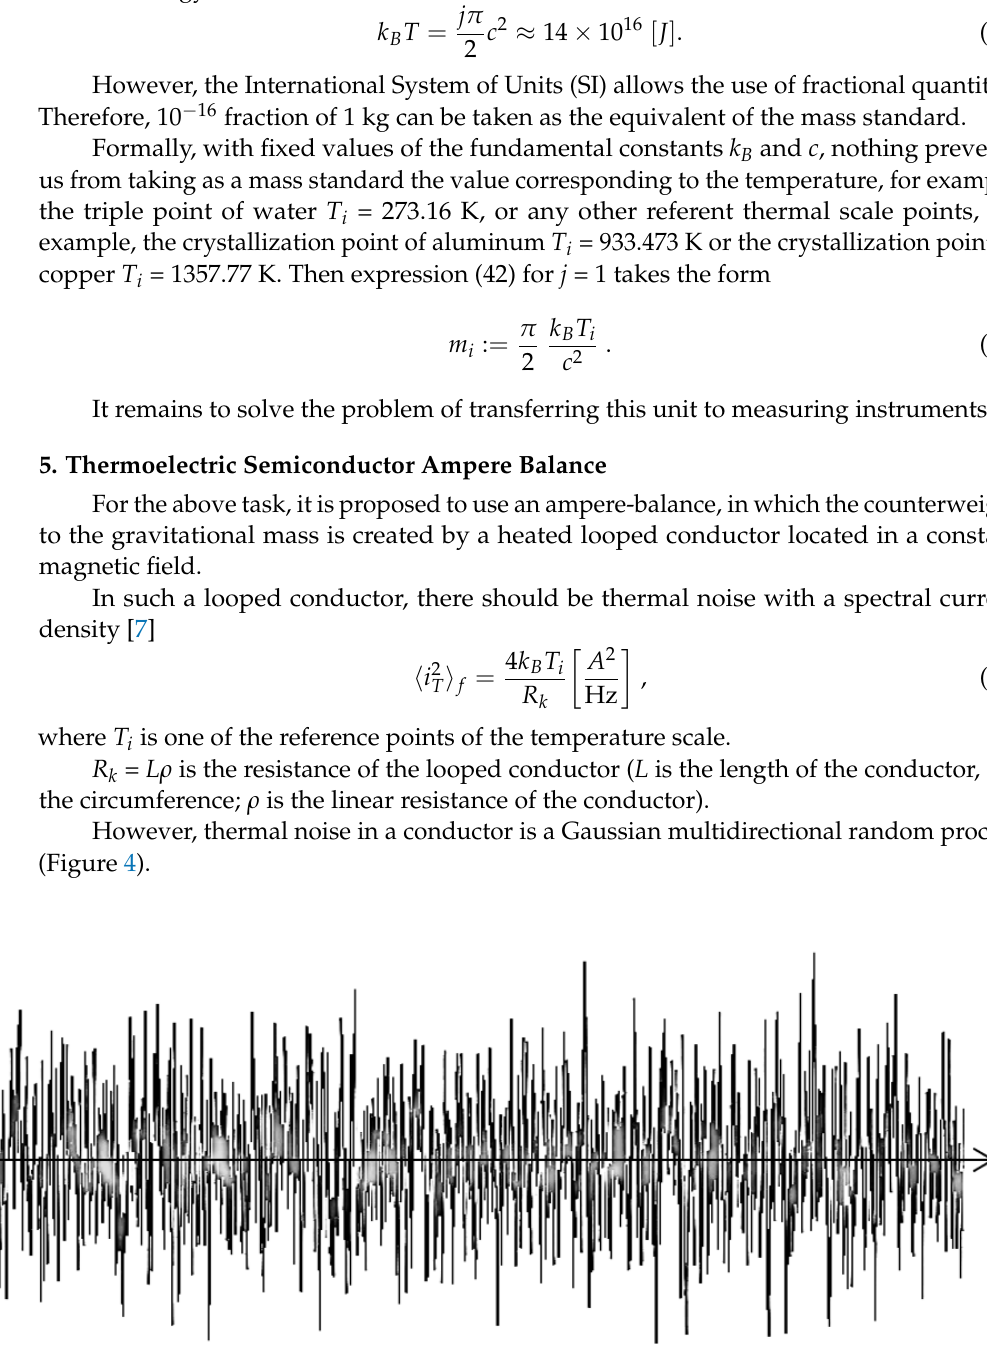
Figure 4. Thermal noise in a looped conductor with resistance R k. .